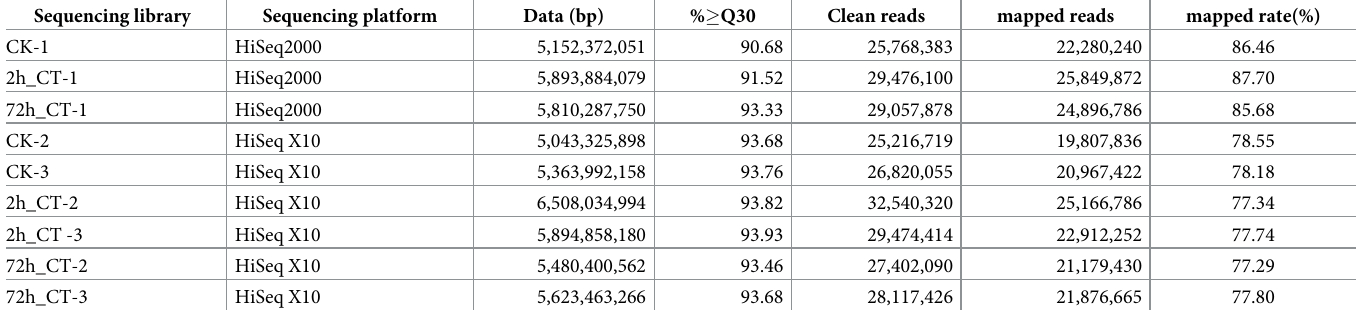
Table 1. Overview of the RNA-seq reads.